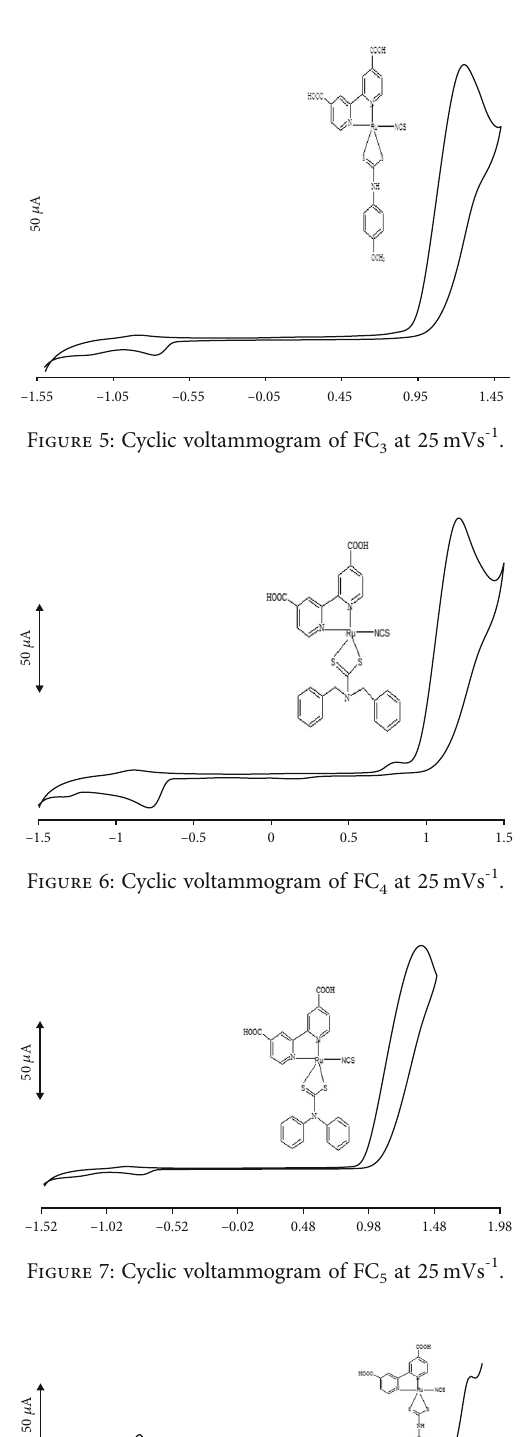
Figure 8: Square wave voltammogram of FC